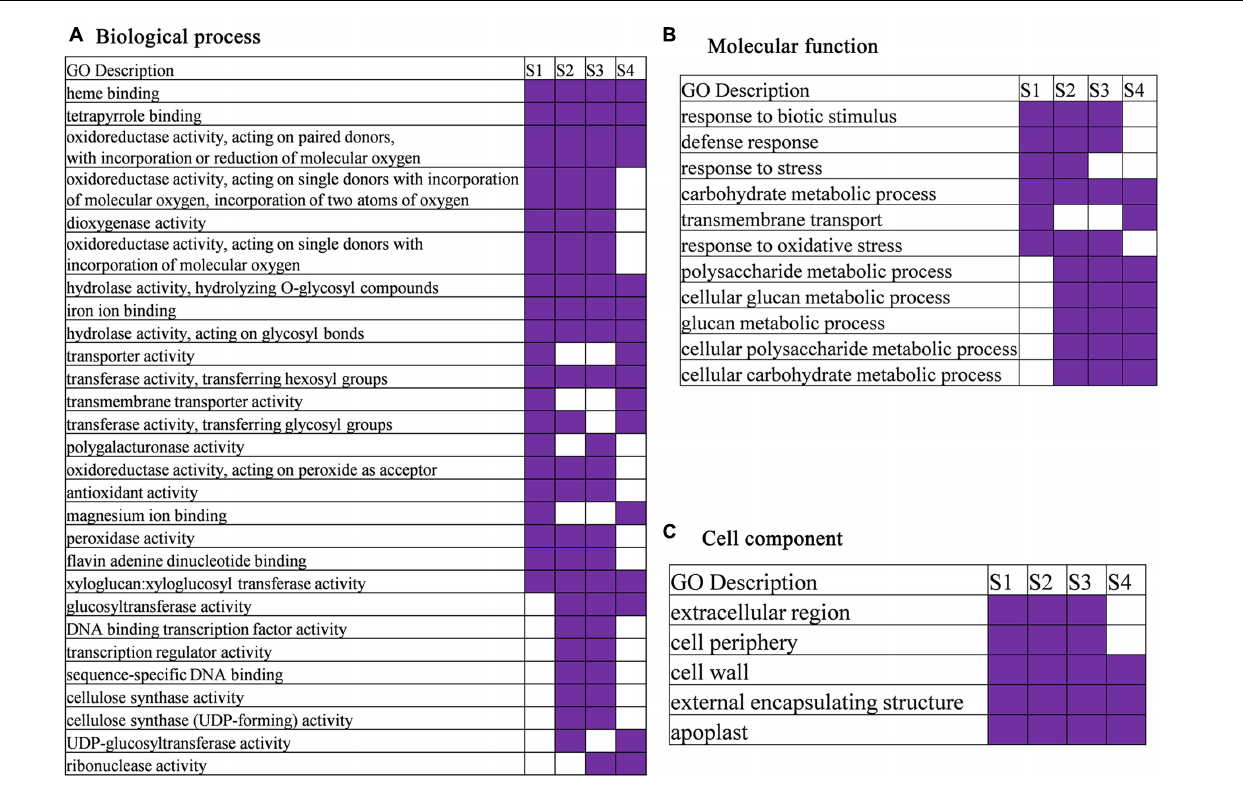
FIGURE 5 | Gene ontology (GO) enrichment heatmap for DEGs in anther development stage (GO terms were selected based on their appearance at least in two times or more). (A) Biological process. (B) Molecular function. (C) Cell component.